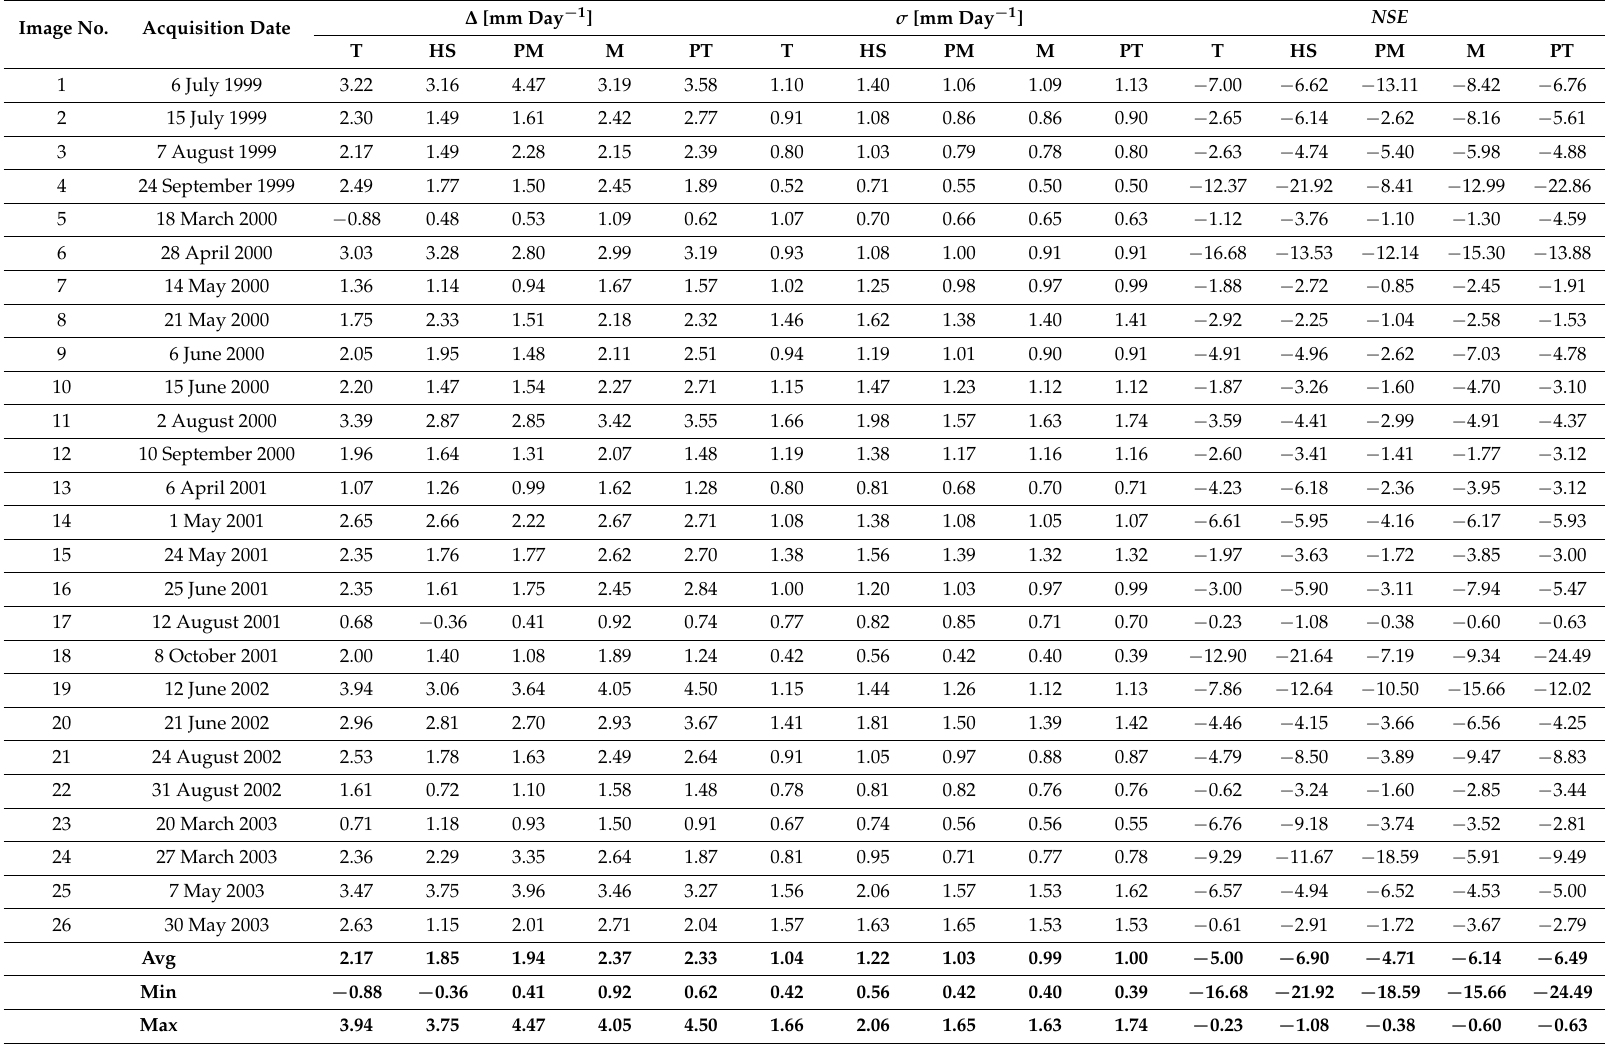
Table 5. Raster residuals ( ∆ ), standard deviations of the residuals ( σ ) and Nash–Sutcliffe efficiency ( NSE ) for PET methods. Image